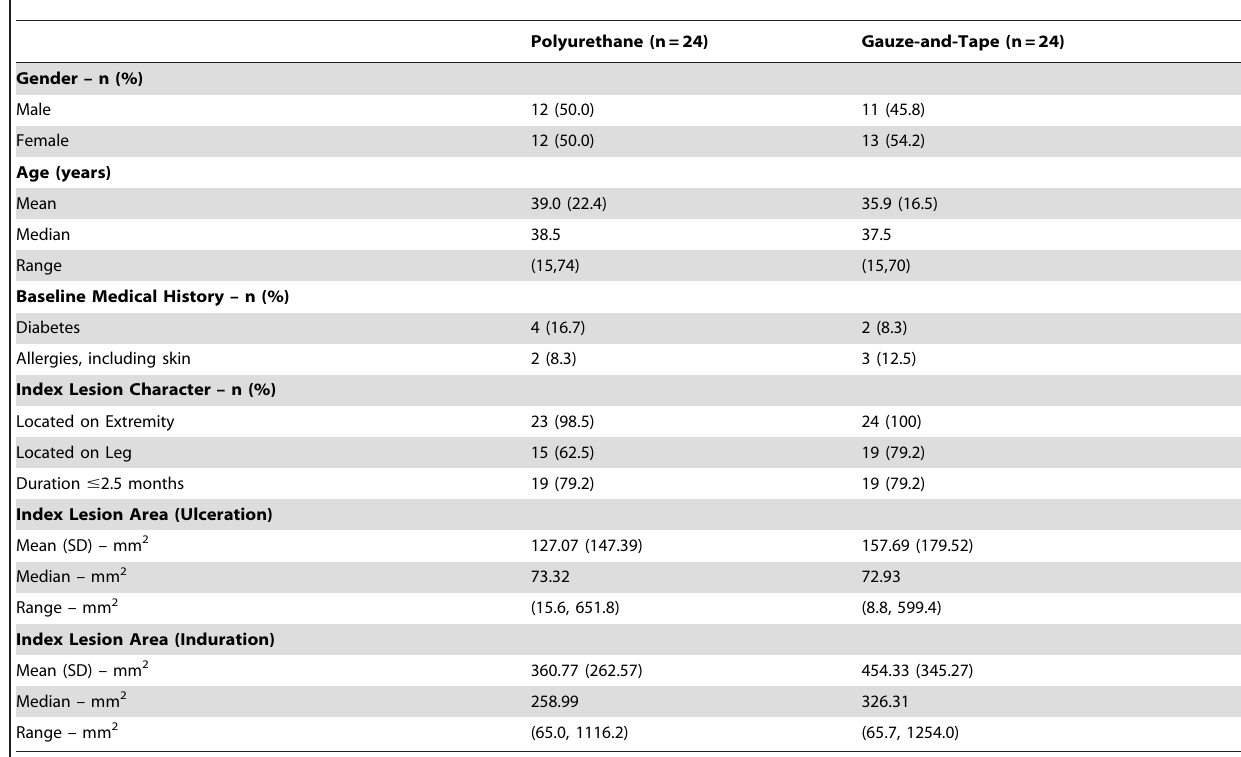
Table 1. Baseline characteristics of study